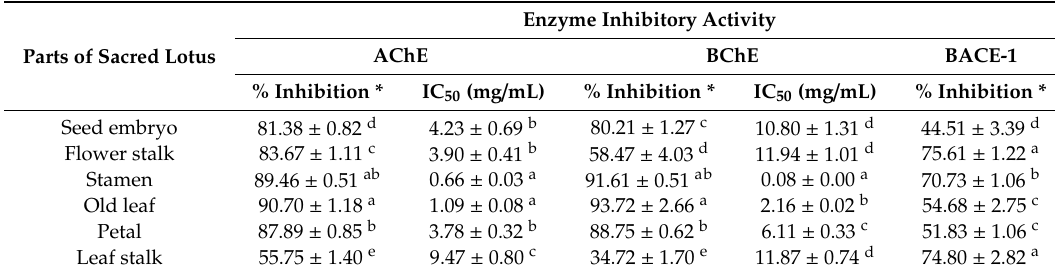
Table 7. Inhibitory activities against acetylcholinesterase (AChE), butyrylcholinesterase (BChE) and beta-secretase (BACE-1) of sacred lotus ( Nelumbo nucifera ) extracts.